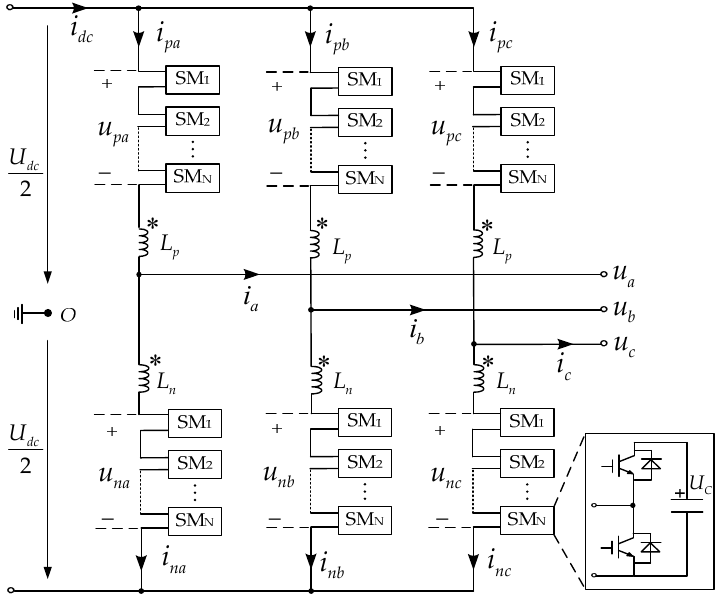
Figure 1. Schematic diagram of three phase modular multilevel converter (MMC). SM: sub-module.